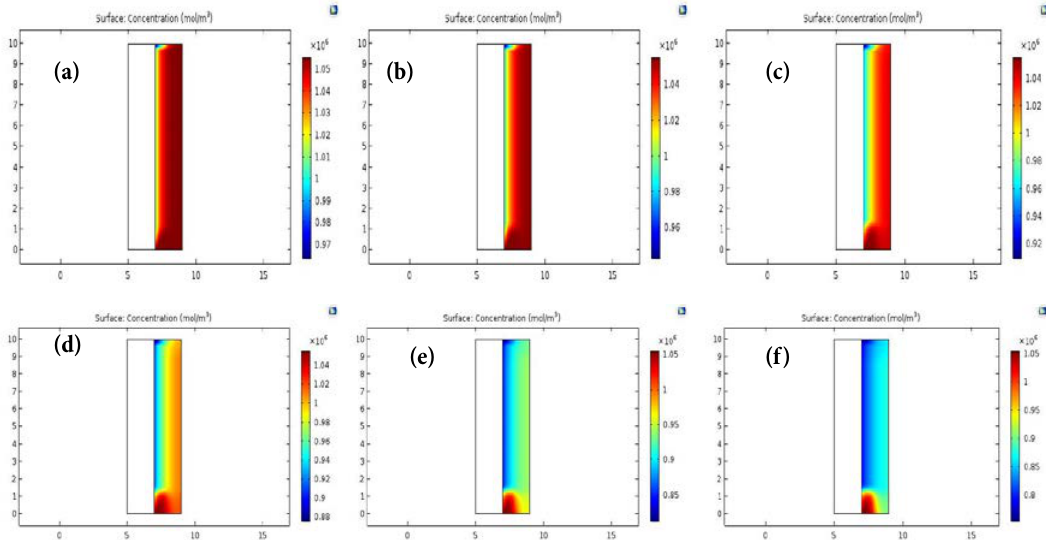
Fig. 8: Concentration distribution of water in feed phase at different separation times (0.5 l/min feed flow rate and 30°C temperature); (a) 1min, (b) 2min, (c) 5min, (d) 10min, (e) 20min and (f)